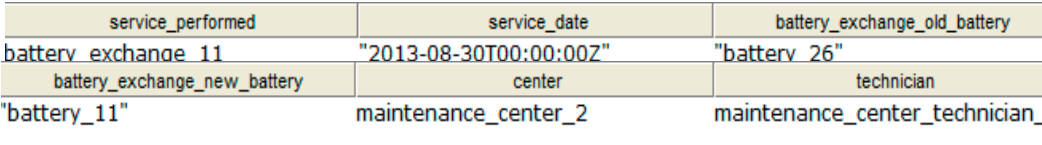
Figure 15. Output produced by Protégé according to the query description.